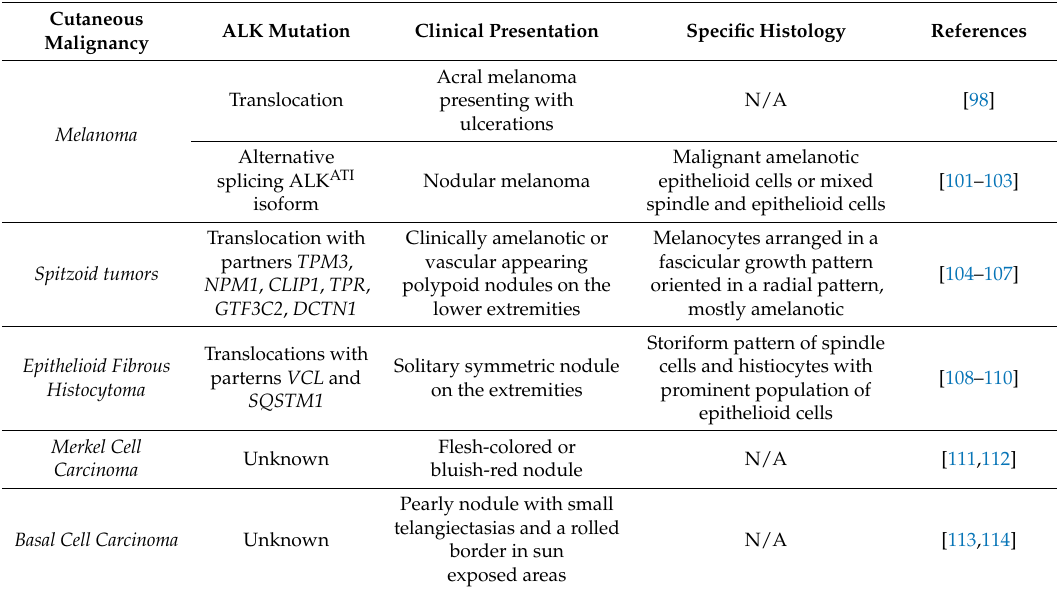
Table 3. ALK in other cutaneous